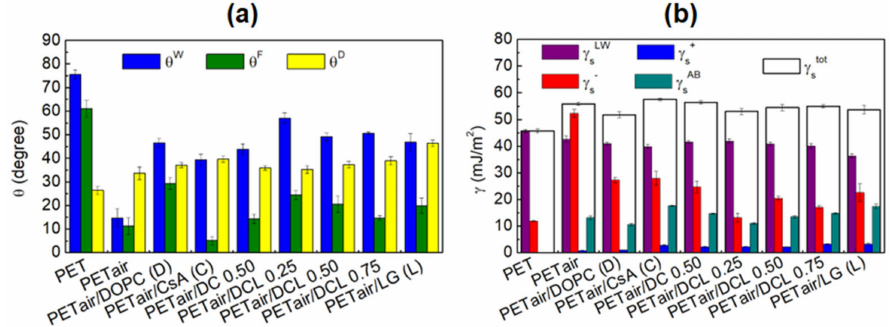
Figure 7. Average advancing contact angles of water, θ W , formamide, θ F , and diiodomethane, θ D , measured onto the unmodified and modified PET surfaces ( a ) and total surface free energy and its components calculated from the LWAB approach ( b ) for the unmodified and modified PET